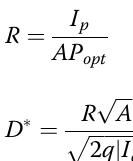
Fig. 3f and g, respectively. The device was evaluated at room temperature, unpackaged, and without optimization.